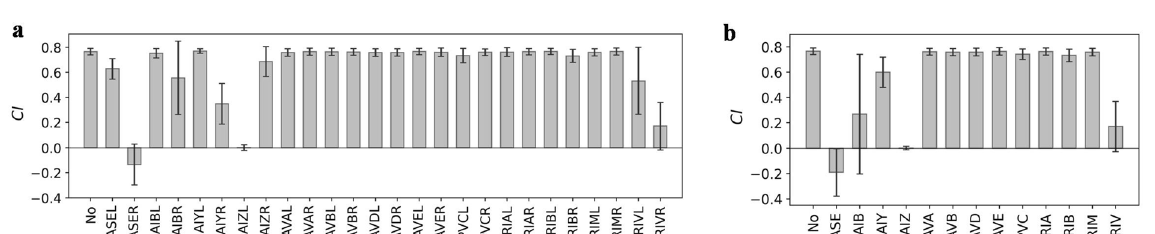
Figure 7. Klinotaxis efficiencies of multiple neuron-ablated random-walk model elegans . ( a ) Simulated ablation of an individual neuron. ( b ) Simulated ablation of a pair of neurons. The gray bar indicates the average CI of models, and the error bar is s.e.m. ( n =